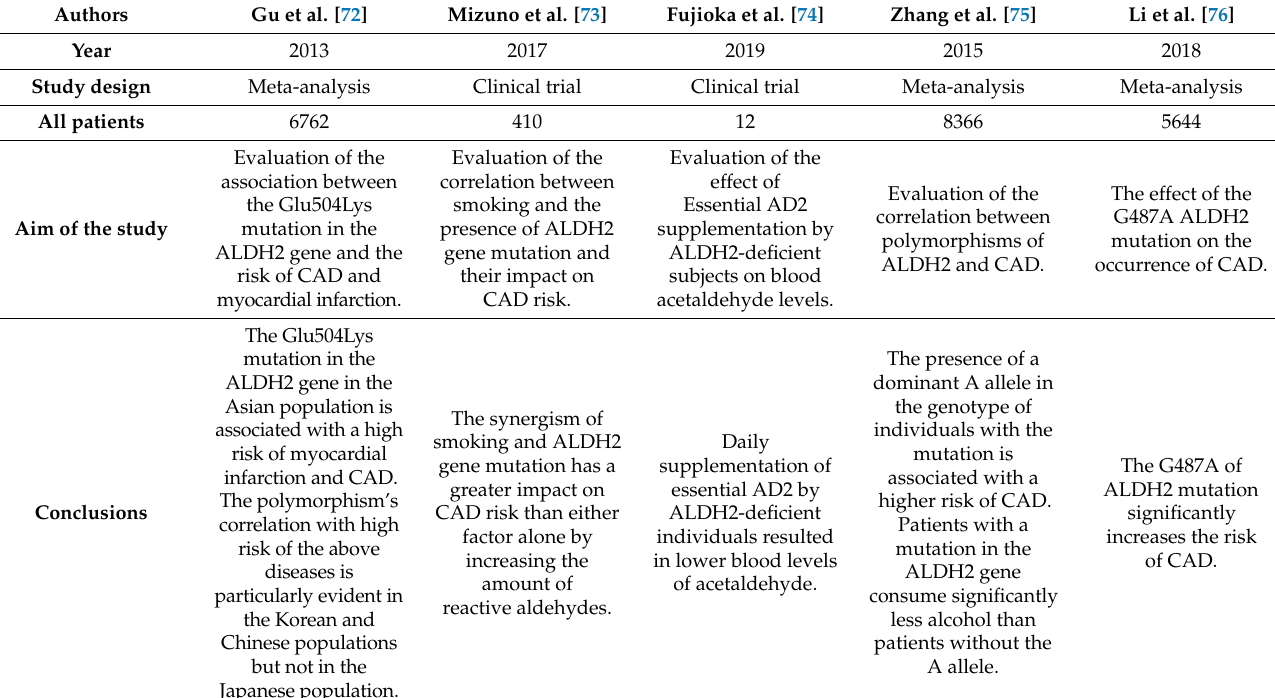
Table 2. Association between mutation in the ALDH2 gene and CAD